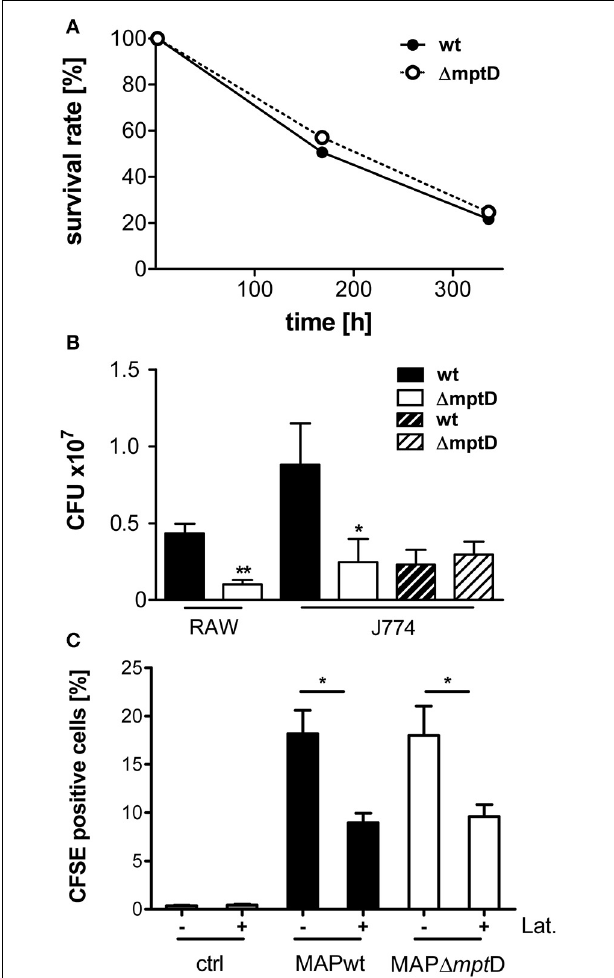
FIGURE 2 | Survival and association of MAPwt and MAP (cid:2) mpt D strain in mouse macrophages. (A) Survival rates of MAPwt and MAP (cid:2) mpt D in RAW264.7 macrophages. Exponentially growing bacteria of MAP (cid:2) mpt D and MAPwt were harvested at OD 600 of 1.0, and single cell suspensions of an OD 600 of 0.1 in DMEM were used to infect murine RAW264.7 macrophages as described in Materials and Methods. CFU were counted at 2h, 8 and 14 days of macrophage infection. Intracellular survival rates were calculated by relating the CFU after 8 and 14 days to those of 2h. (B) CFU numbers of bacteria after infection of mouse macrophages (RAW264.7/J774.A1) with MAPwt and MAP (cid:2) mpt D for 2h (filled bars) and after incubation of the strains in macrophage cell lysates for 2h (dashed bars). The results represent the mean ± standard error (s.e.m.) of at least three independent replicates for the macrophage infections and two replicates for the incubation in macrophage lysates. (C) Association and invasion of CFSE labeled MAP wild type and MAP (cid:2) mpt D strains in J774.A1 macrophages after 2h incubation with ( + ) and without ( − ) latrunculin (Lat.). The statistical analysis was performed using a parametric t -test (CFU) or a One-Way ANOVA combined with Dunnett’s multiple comparison test (CFSE experiments). A p -value ≤ 0.05 was defined as statistically significant ( ∗∗ p < 0 . 005; ∗ p < 0 .